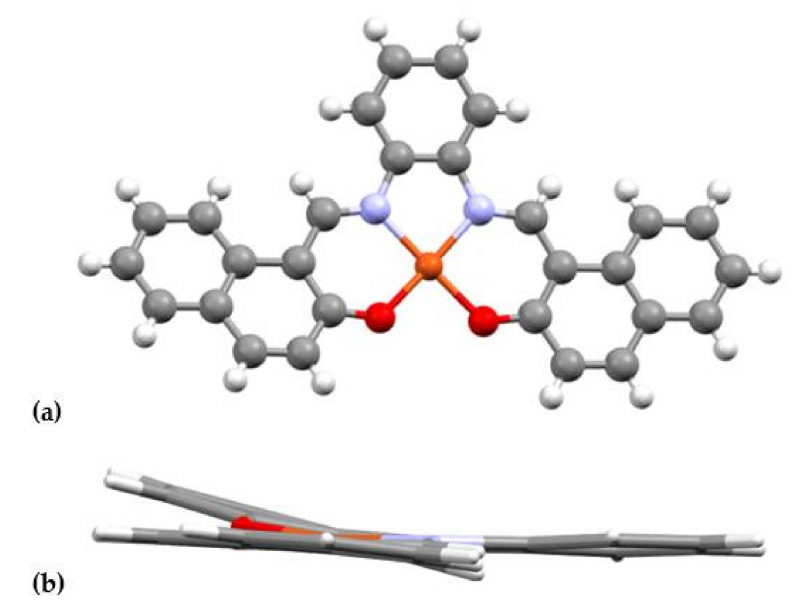
Figure 1. ( a ) Crystal structure of SYML1-Cu. Carbon: gray, hydrogen: white, oxygen: red, nitrogen: blue, Cu(II): orange. ( b ) Side view of SYML1-Cu, showing the distortion from planarity. SYML1-Fe crystallizes in the monoclinic space group C 2 / c. The crystal structure is shown in